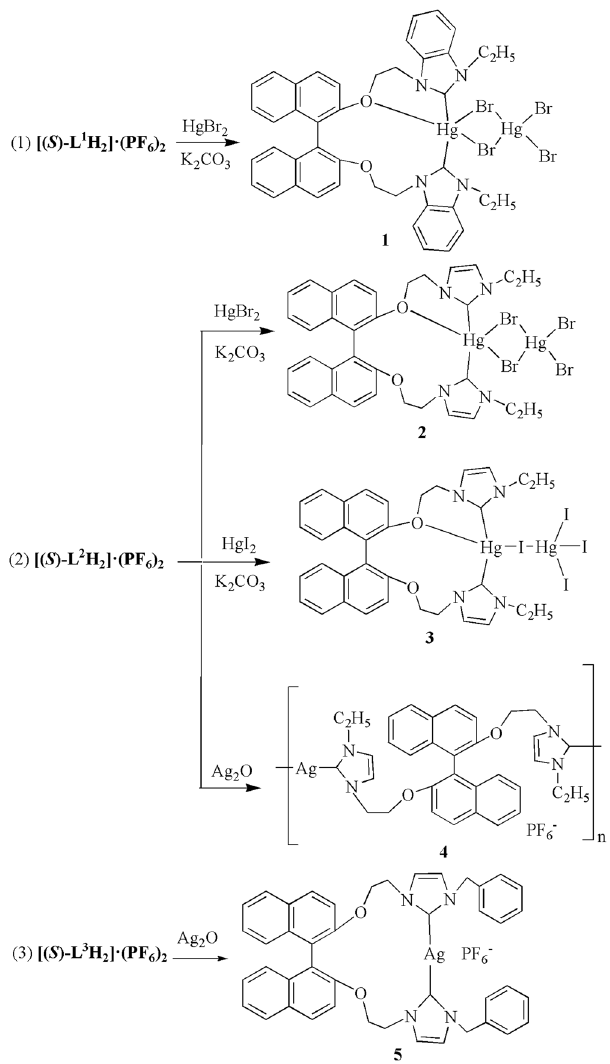
Figure 2. Preparation of complexes 1 – 5